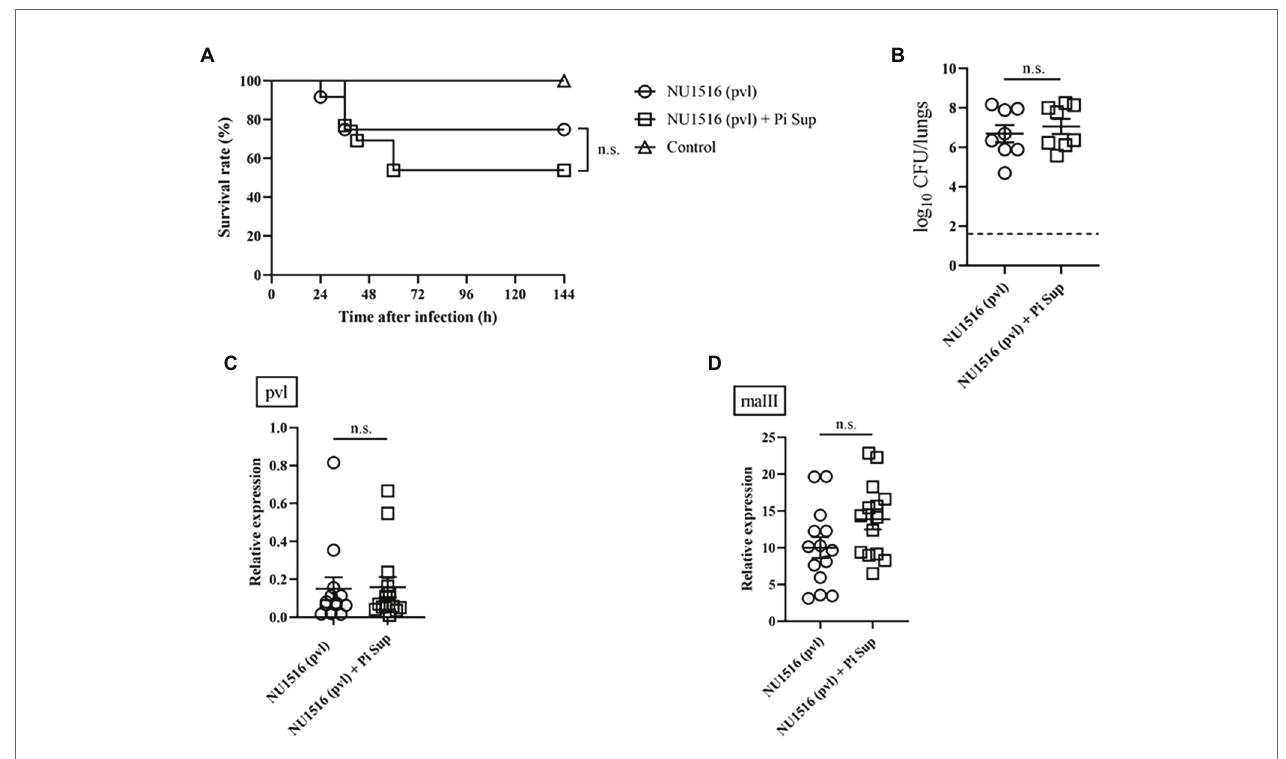
FIGURE 5 | (A) Survival rates and (B) bacterial loads of mice infected with the NU1516 panton-valentine leucocidin (PVL)-producing MRSA strain with/without Pi Sup. O , NU1516-infected mice without Pi Sup; ◽ , NU1516-infected mice with Pi Sup; and △ , broth-inoculated mice. Bars represent mean bacterial counts, n = 6–12 mice/group. The broken horizontal line represents the lower limit of detection (1.7 log10 CFU/ml of lung specimen). Similar results were obtained from two independent experiments. Transcript levels of (C) pvl and (D) rnaIII measured 16 h after inoculation in mice infected with NU1516 MRSA with/without Pi Sup. Bars represent the mean relative mRNA expression. Data are representative of 6–8 mice from two independent experiments. n.s., not